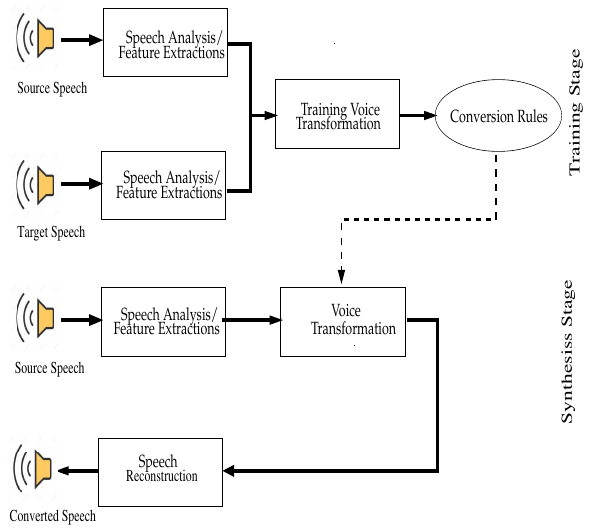
Figure 1. Typical voice transformation